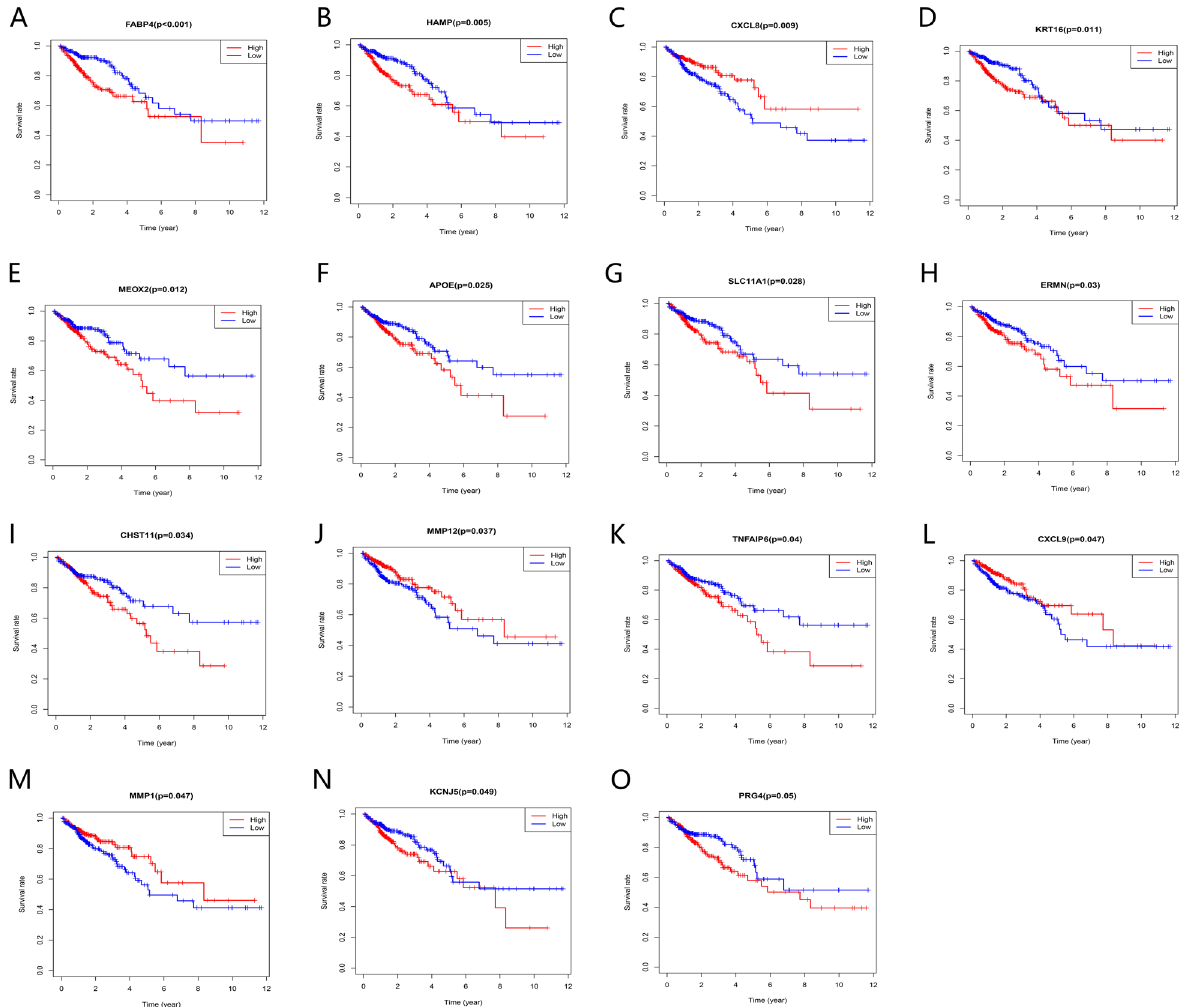
Figure 5. Association between the TME-related DEGs expressions and overall survival in TCGA. Fifteen genes were found to be related to CRC patients’ survival. p <